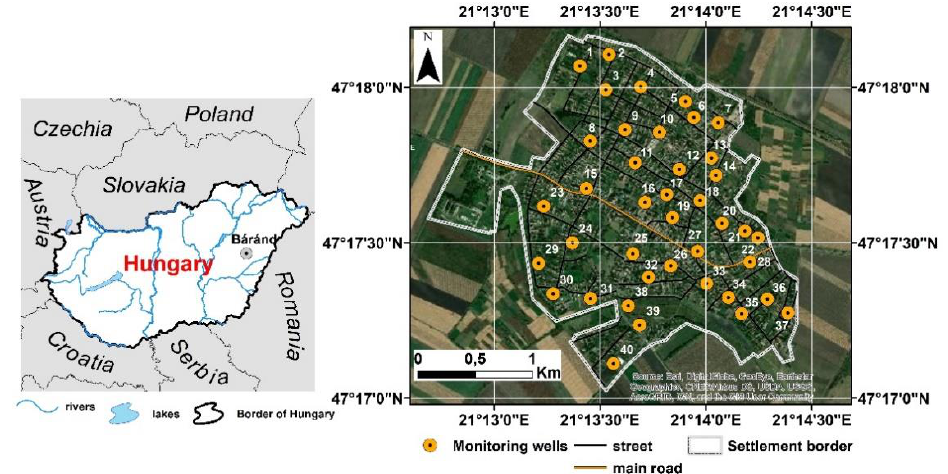
Figure 1. Location of study area and investigated wells.